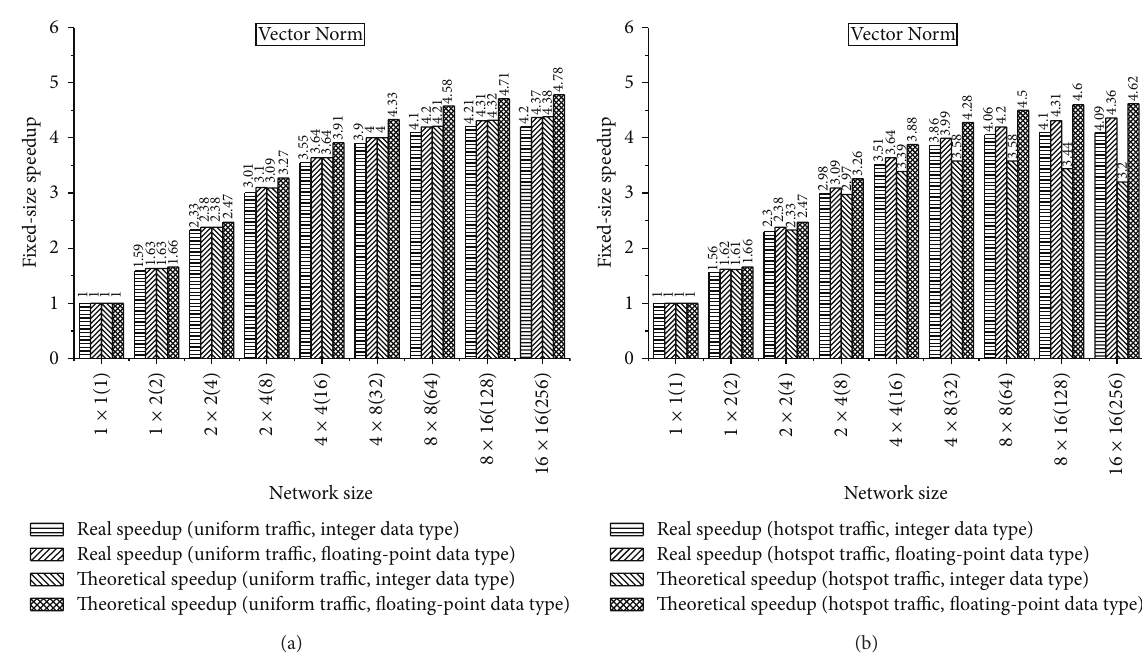
Figure 16: Effect of noncommunication/communication ratio: Vector Norm with (a) uniform traffic model and (b) hotspot traffic